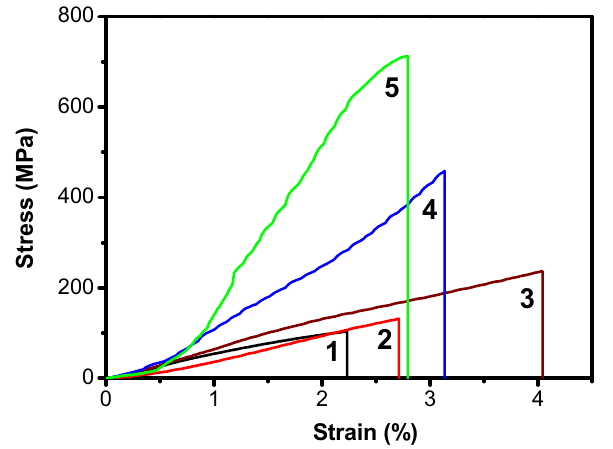
Figure 9. Tensile stress–strain curves of GO (Curve 1), rGO (Curve 2), rGO/PDA (Curve 3), P-GP (Curve 4), and P-GCP (Curve 5).